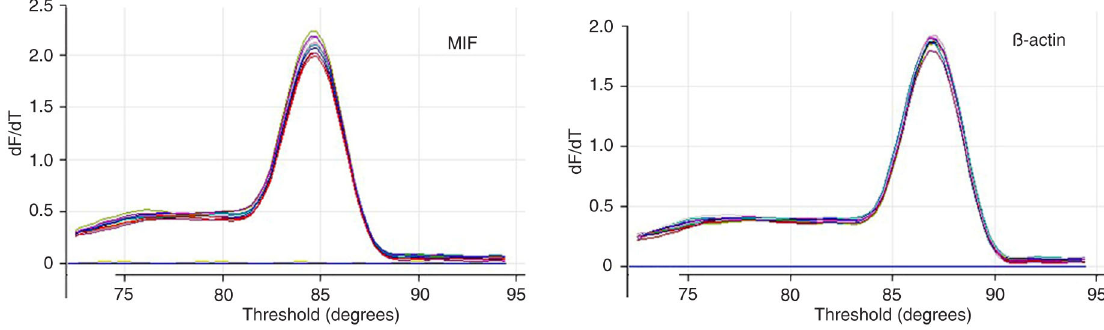
Figure 1. Melting curves of migration inhibitory factor (MIF) mRNA and b -actin mRNA. The melting temperature is uniform and the shapes of the peaks are sharp, which indicate that MIF and b -actin are the only amplicons in the amplification